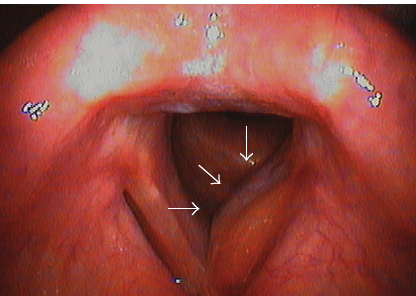
Figure 1: A submucosal swelling of the left subglottic trachea (arrow) by fiberscopic